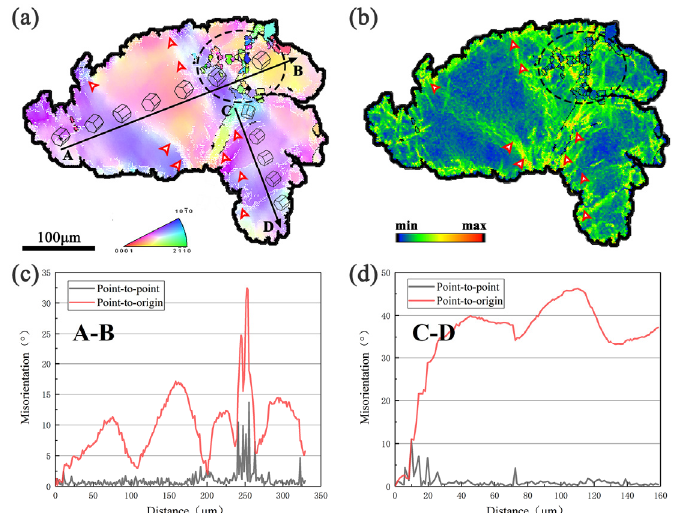
Figure 8. The typical kinked grain selected in the sample at 1 pass: ( a ) OIM map; ( b ) kernel average misorientation (KAM) distribution map; ( c ) line graph of misorientation angle along the AB in ( a ); ( d ) line graph of misorientation angle along the CD in ( a ).